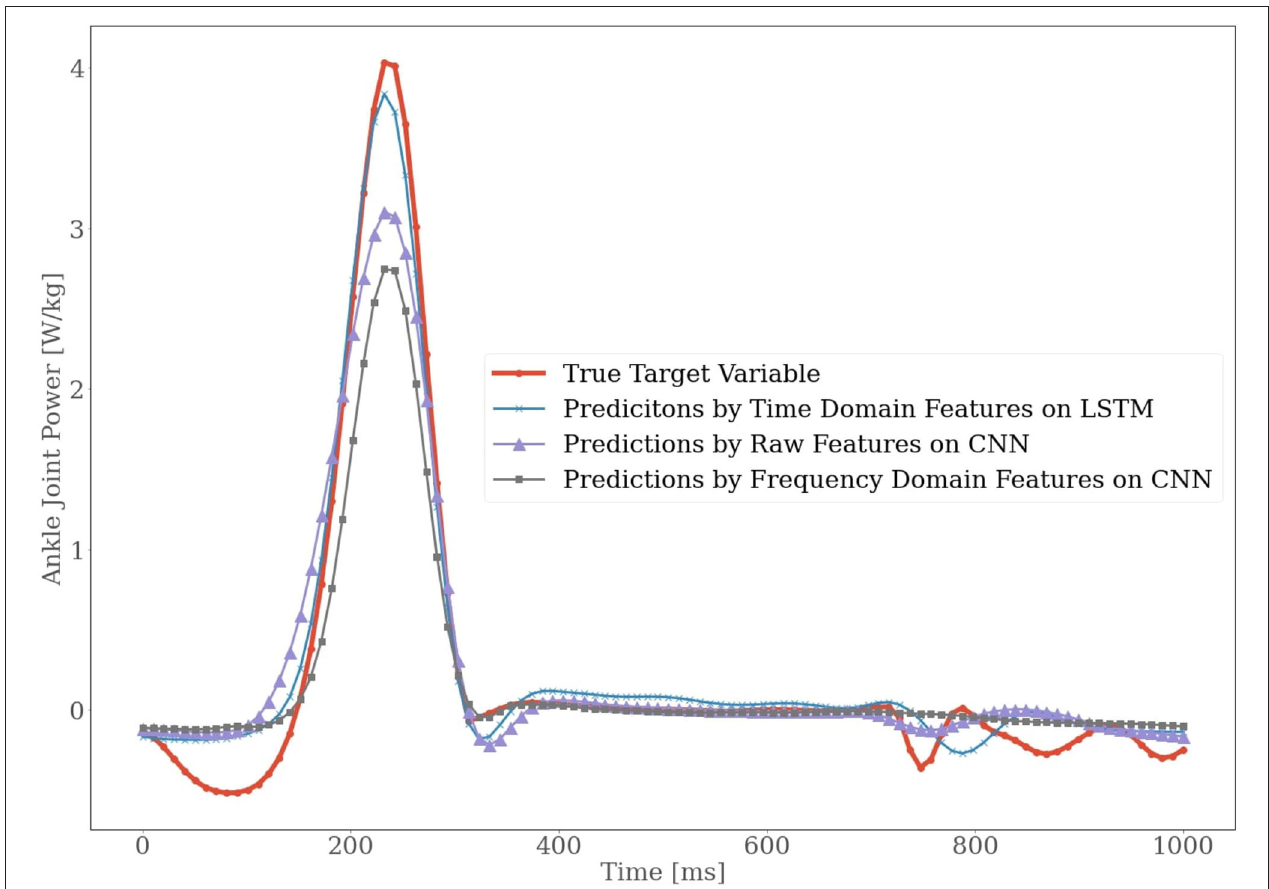
FIGURE 5 | The True target variable is overlayed with the predictions from the two models Long-Short Term Memory (LSTM) and Convolutional Neural Network (CNN). This excerption presents participant 3 for the velocity of 1.6